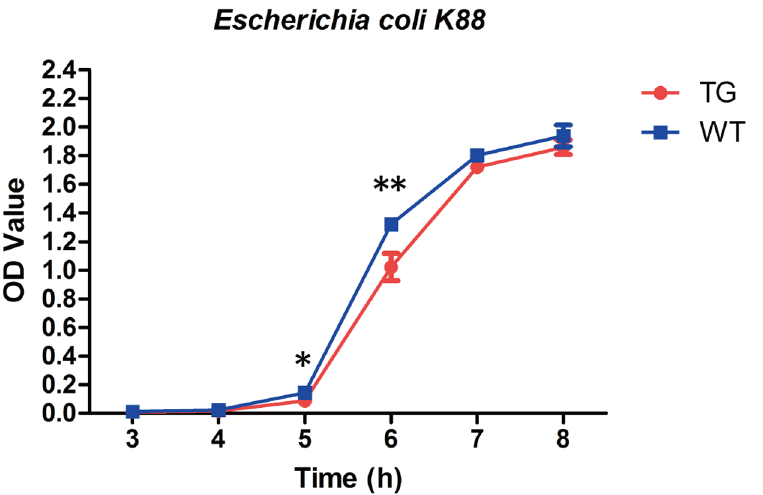
Fig 4. The influence of rhLZ milk on growth of E . coli K88. The influence of rhLZ transgenic milk on the growth of E . coli K88. Values are showed as means ± standard deviations. The growth of individual bacterial strains in the presence of milk from transgenic pigs was significantly different from controls ( * p < 0.05, ** p <